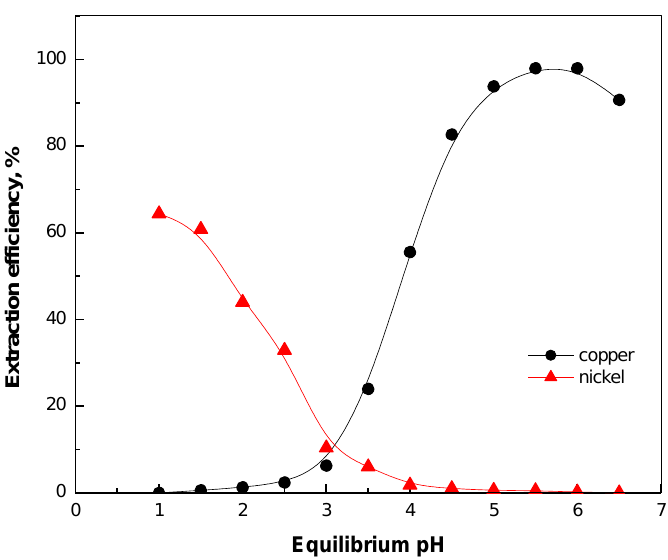
Fig. 9. Effect of equilibrium pH on extraction of copper (II) and nickel (II), Conditions: O/A = 1, Na 2 SO 4 = 0.5 mol L -1 , 15% (v/v) furfuryl thioalcohol in kerosene, equilibrium time 10